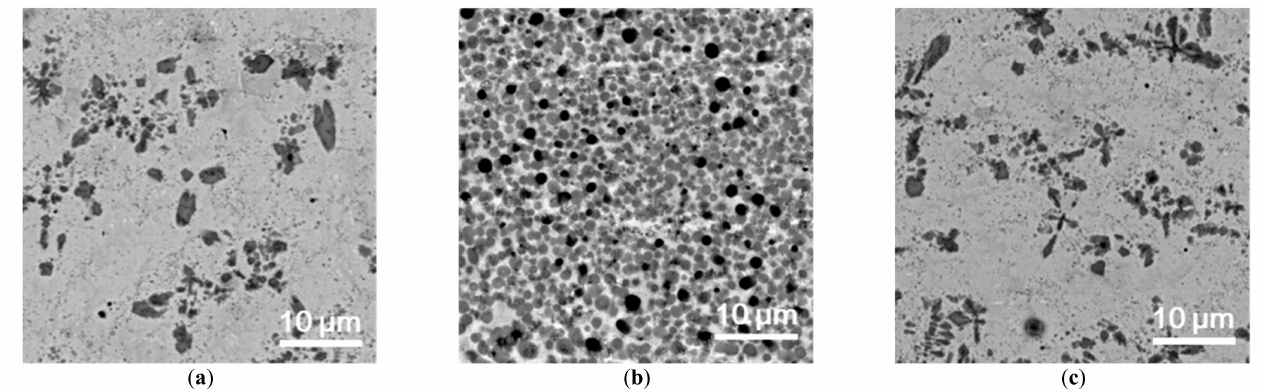
Figure 5. Microstructure at the ( a ) top part, ( b ) center part, and ( c ) bottom part of EEMMC1.0. EEMMC1.5 has a thicker coating layer with more heat input than EEMMC1.0. The microstructure of EEMMC1.5 is shown in Figure 6 by dividing the coating layer into three parts in the depth direction, as shown in Figure 3, and the particle distribution seen in EEMMC1.0 disappeared, and the particles were distributed relatively